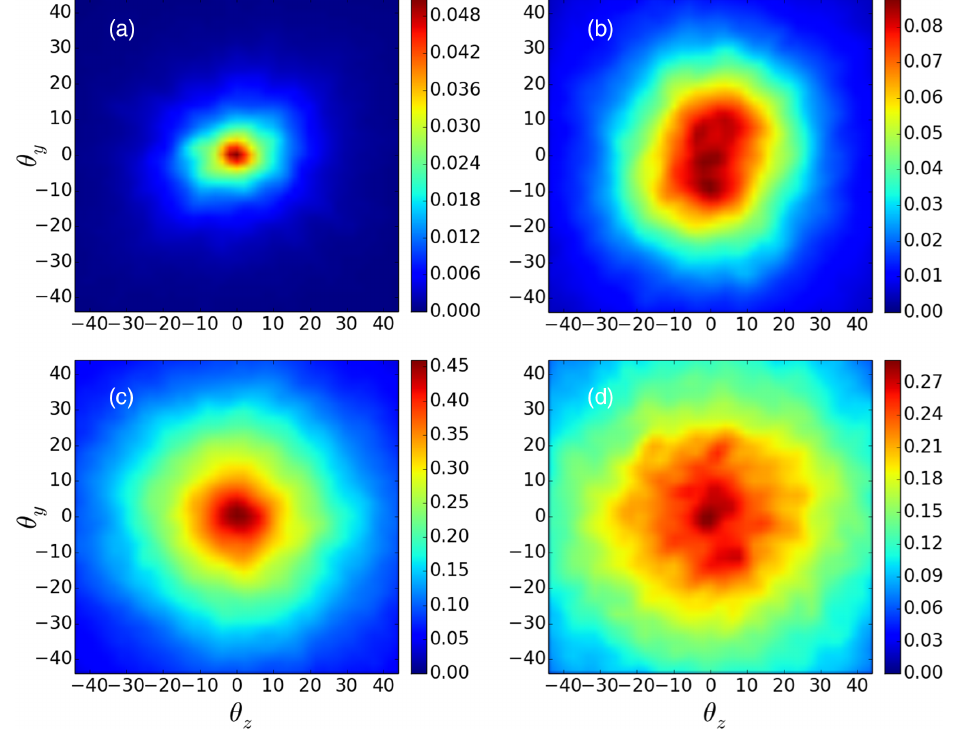
2 . 8 × 10 17 cm − 3 , e ¼